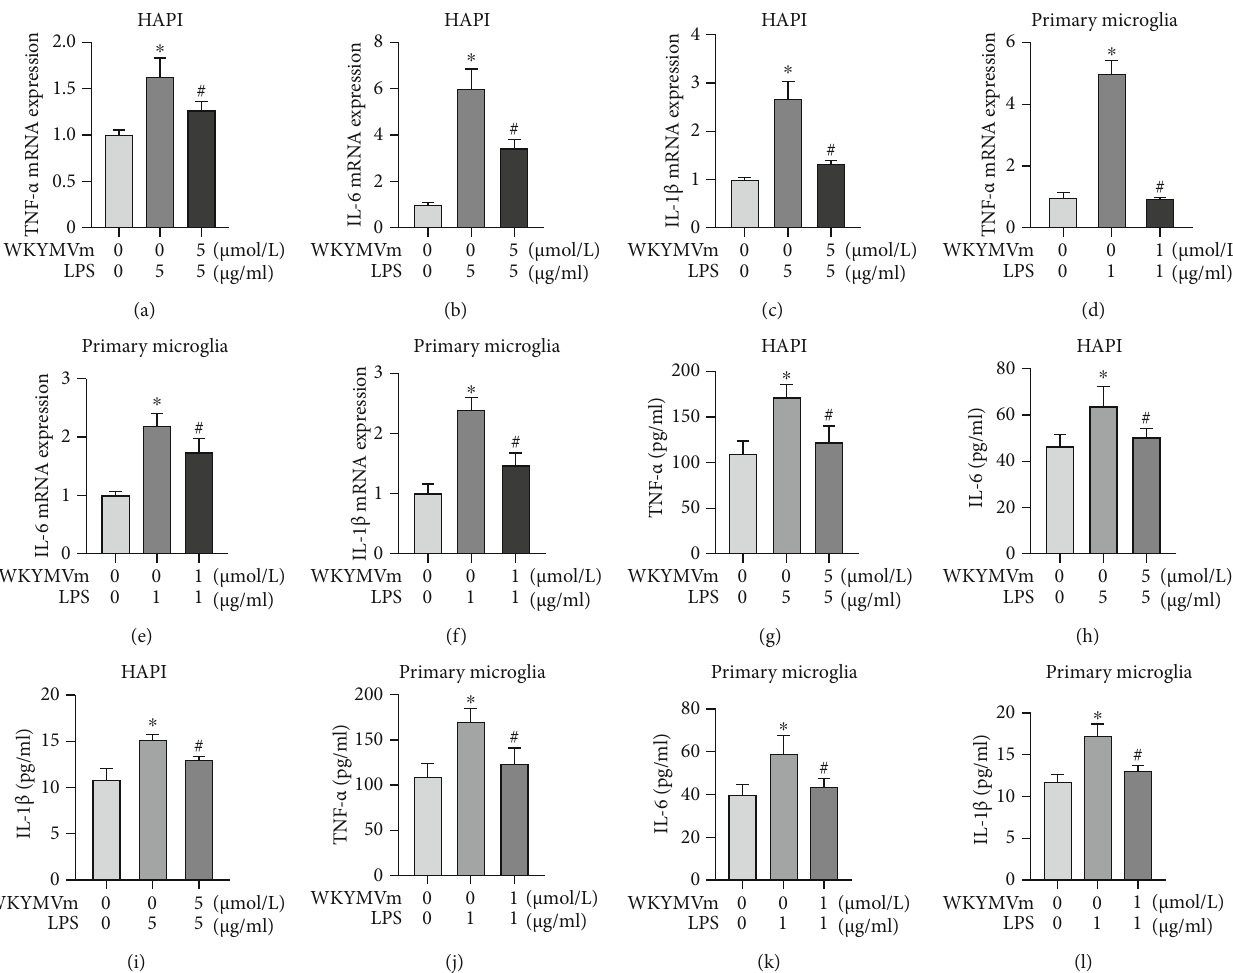
Figure 3: WKYMVm inhibited in fl ammatory cytokine production in microglial cells. (a – c) Expression levels of TNF- α , IL-6, and IL-1 β in HAPI microglia from each group were detected by RT-PCR assay. (d – f) mRNA levels of TNF- α , IL-6, and IL-1 β in primary microglia from each group. (g – i) The protein content of TNF- α , IL-6, and IL-1 β in the supernatant of the HAPI microglia culture medium was detected by ELISA. (j – l) The protein level of TNF- α , IL-6, and IL-1 β in the supernatant of the primary microglia culture medium. ∗ p < 0 : 05 vs. the control group; # p < 0 : 05 vs. the LPS